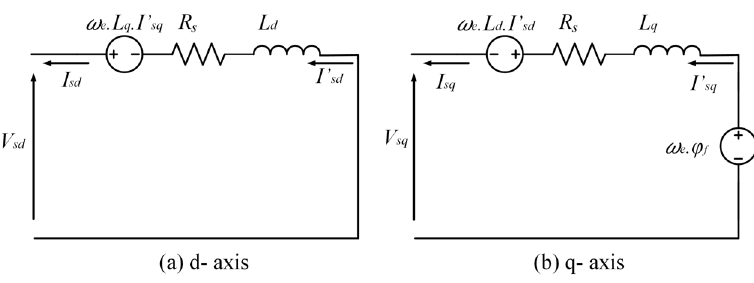
Figure 3. The short circuit turns ratio representation.